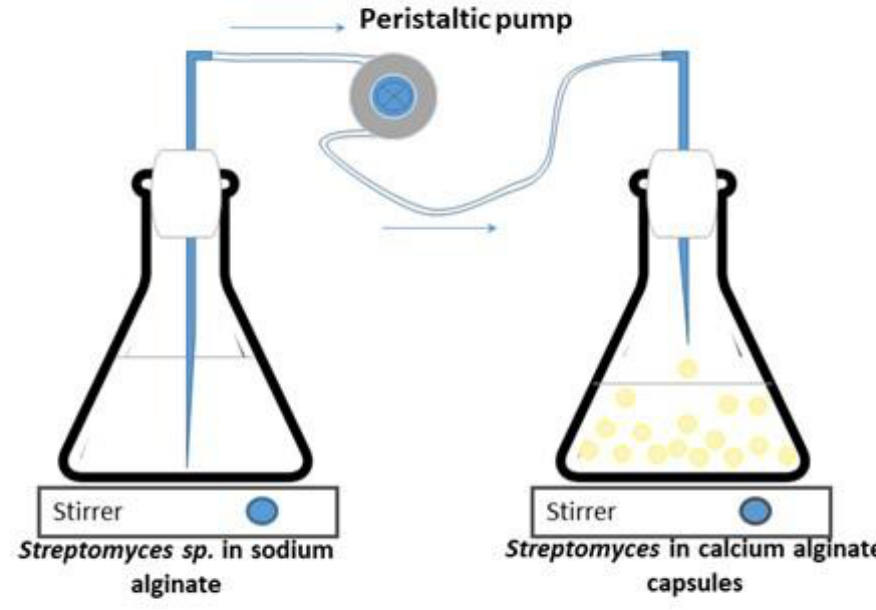
Figure 2. Immobilization of Streptomyces CDBB1232 in calcium alginate capsules.